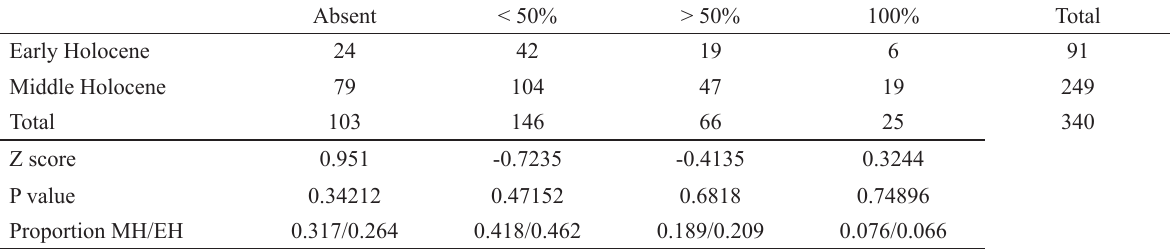
Amount of cortex, Z-test results (z score and p value) and proportion between Middle Holocene (MH) and Early Holocene (EH) flakes.